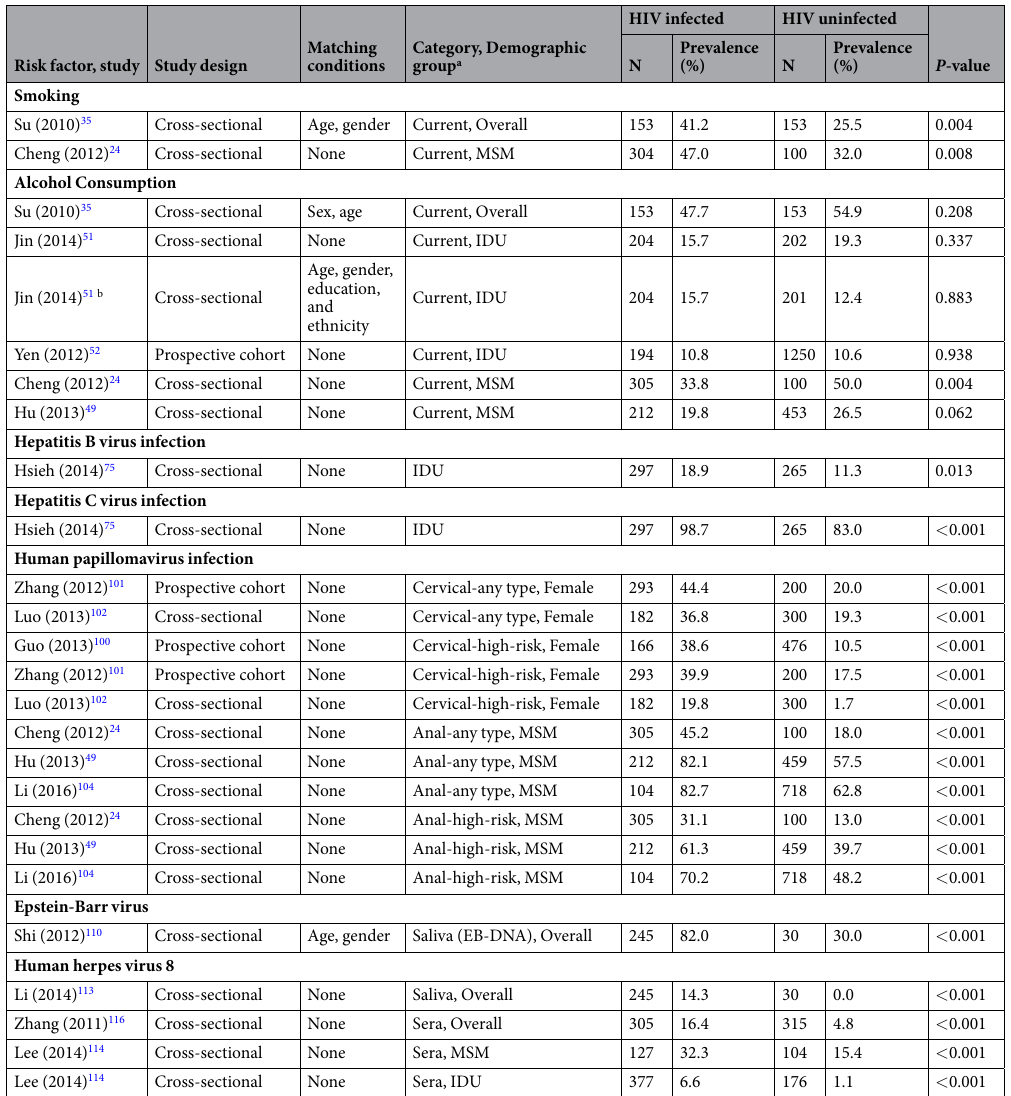
Table 4. Comparison of prevalence of cancer risk factors between HIV infected and uninfected groups from the same study. a Demographic versus between HIV infected and uninfected group: Overall VS General, Female VS General female, MSM VS MSM, and IDU VS IDU. b HIV uninfected controls were enrolled from non-IDU